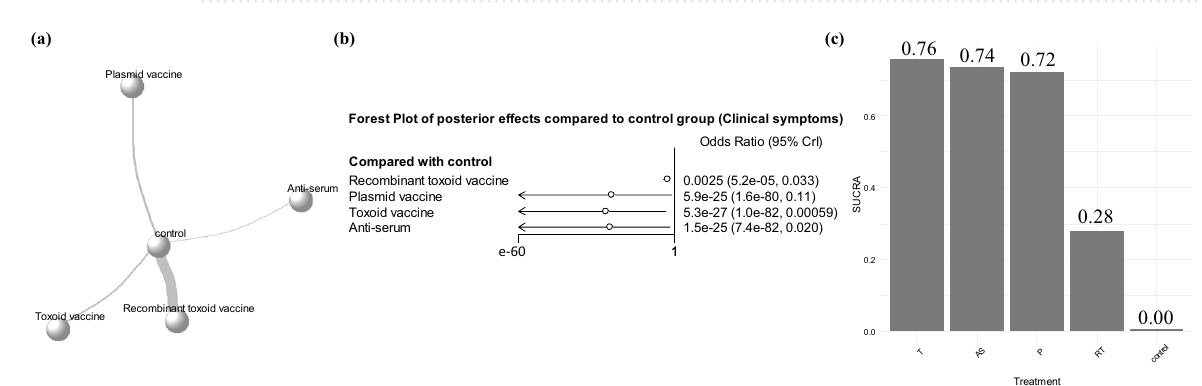
Figure 5. Results of network meta-analysis of edema disease-related mortality in pigs. ( a ) Network plot for mortality. Each circle represents a vaccine type, and width of lines between circles indicates number of pairs. ( b ) Forest plot of posterior effects compared to control group based on their odds ratio (OR). ( c ) Surface under the cumulative ranking curve (SUCRA) plot for mortality. P, plasmid-based DNA vaccine; T, toxoid vaccine; AS, anti-serum; RT, recombinant toxoid vaccine. The statistical program R (version 4.1.1) was used to prepare this figure 44 .